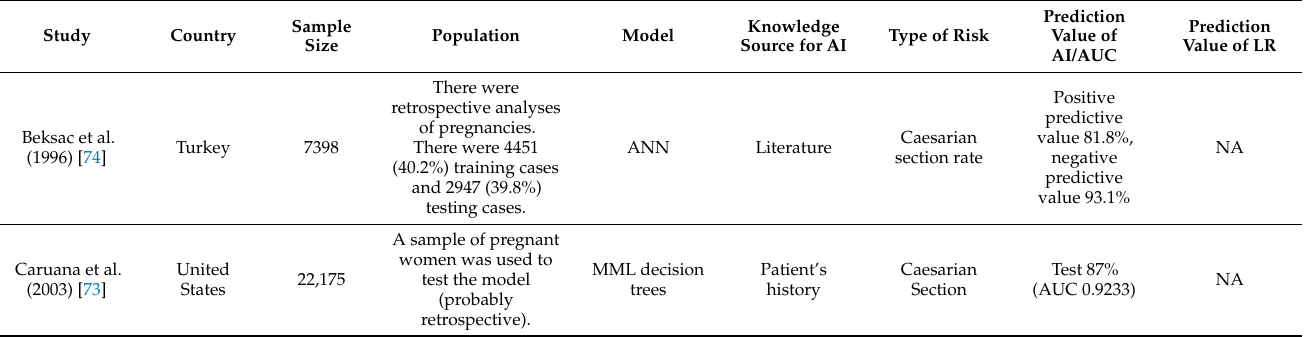
Table 9. Characteristics of included studies on delivery